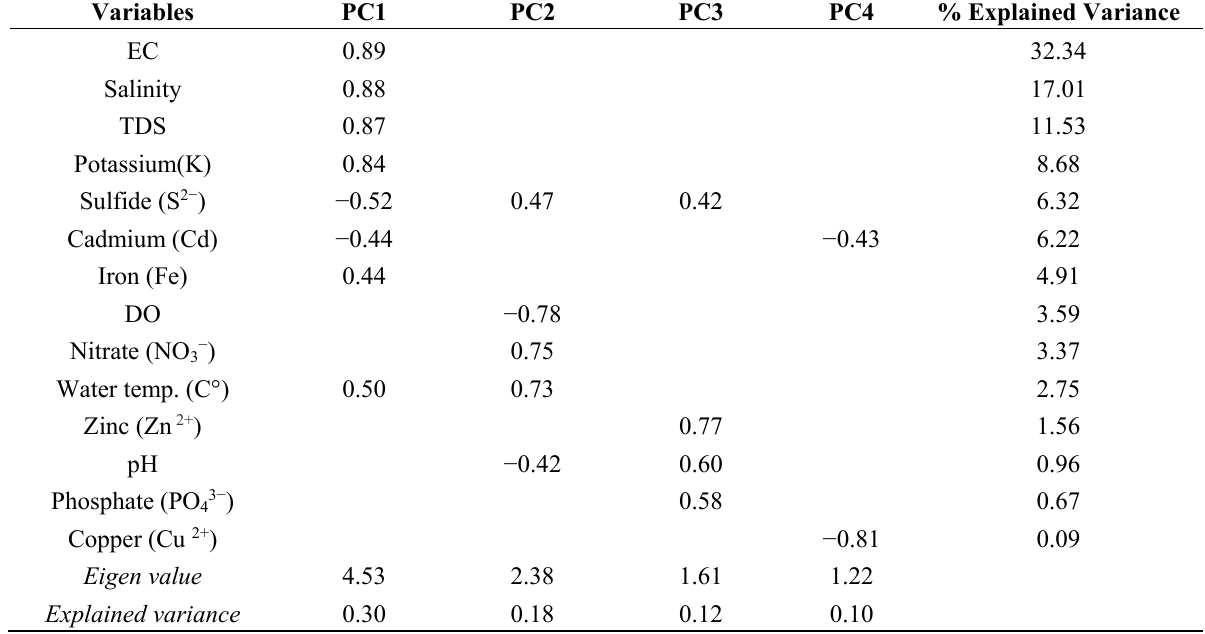
Table 2. Results of PCA for all 38 sites located on main rivers in Meru and Laikipia regions. Loadings with absolute values <0.4 were omitted